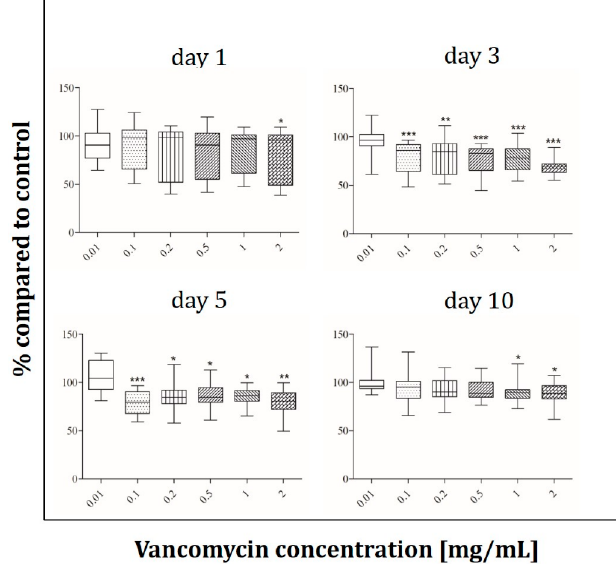
Figure 6. Proliferation of fibroblasts after exposure to vancomycin for 1, 3, 5 and 10 days with change of antibiotic every 4 days (* p < 0.05; ** p < 0.01; *** p < 0.001 to control). The results are presented in percentage of the control without vancomycin (100%).